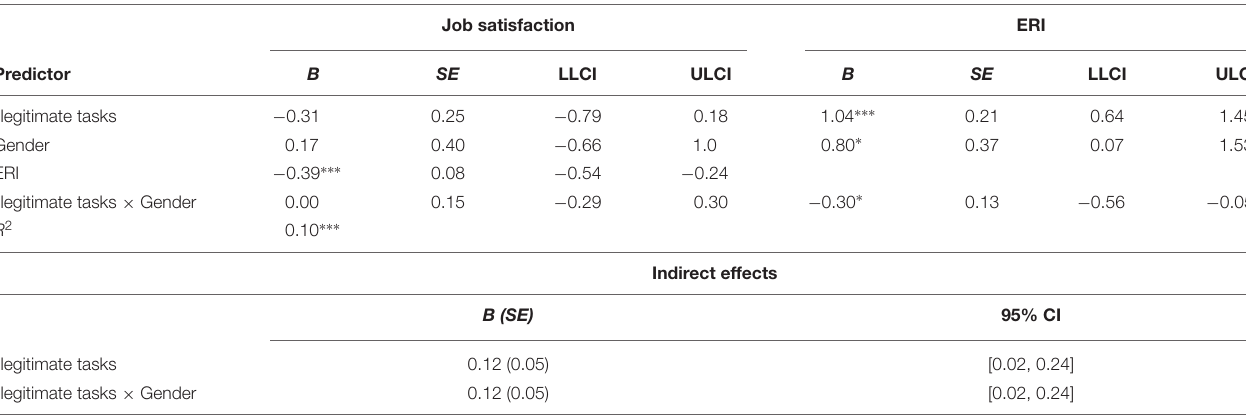
TABLE 2 | Results of test of moderated mediation with job satisfaction as outcome.